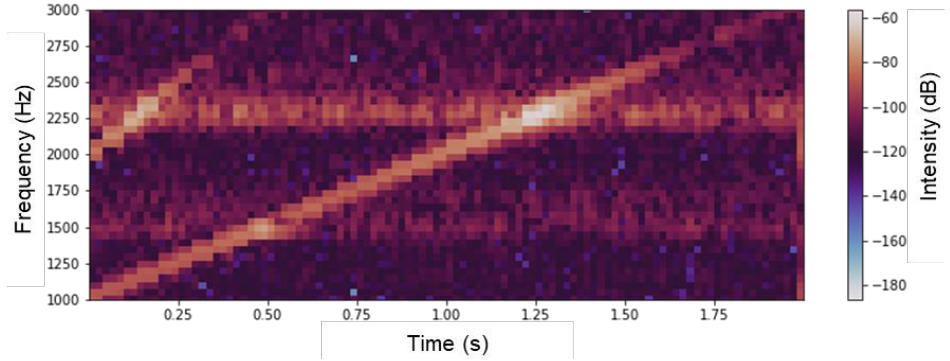
Figure 4. Spectrogram of the vibration of copper disk evaluated from Figure 2a.